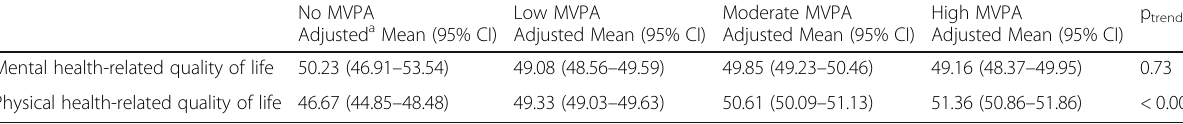
Table 2 Association between accelerometer-measured MVPA and health-related quality of life: